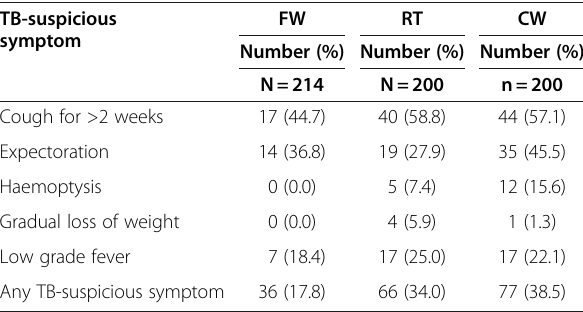
Table 5 TB-suspicious symptoms of migrant workers by occupation